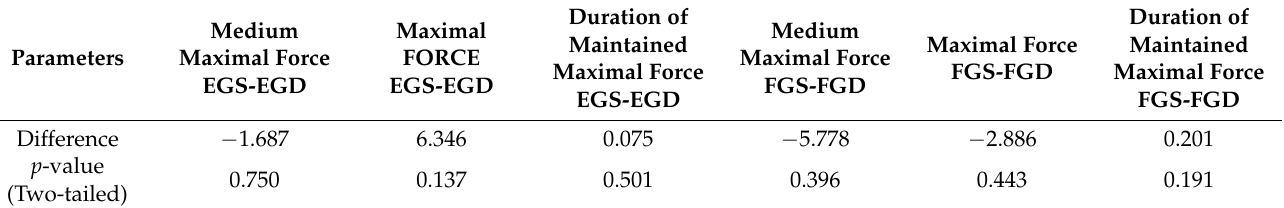
Table 11. Statistical results, left- and right-hand